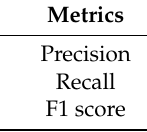
Figure 5. Examples of segmentation results in the test set across different videos: ( a – c ) high overlap between references (dotted) and AI-based (drawn through) segmentation in different states (open, closed) and light conditions, ( d ) segmentation errors of partially visible glottis close to the image edge, ( e ) correct detection of aspiration, ( f ) missed detection of aspiration, ( g ) false-positive detec- tion of aspiration, ( h ) false-positive segmentation of glottis and vocal cords on frame without visible